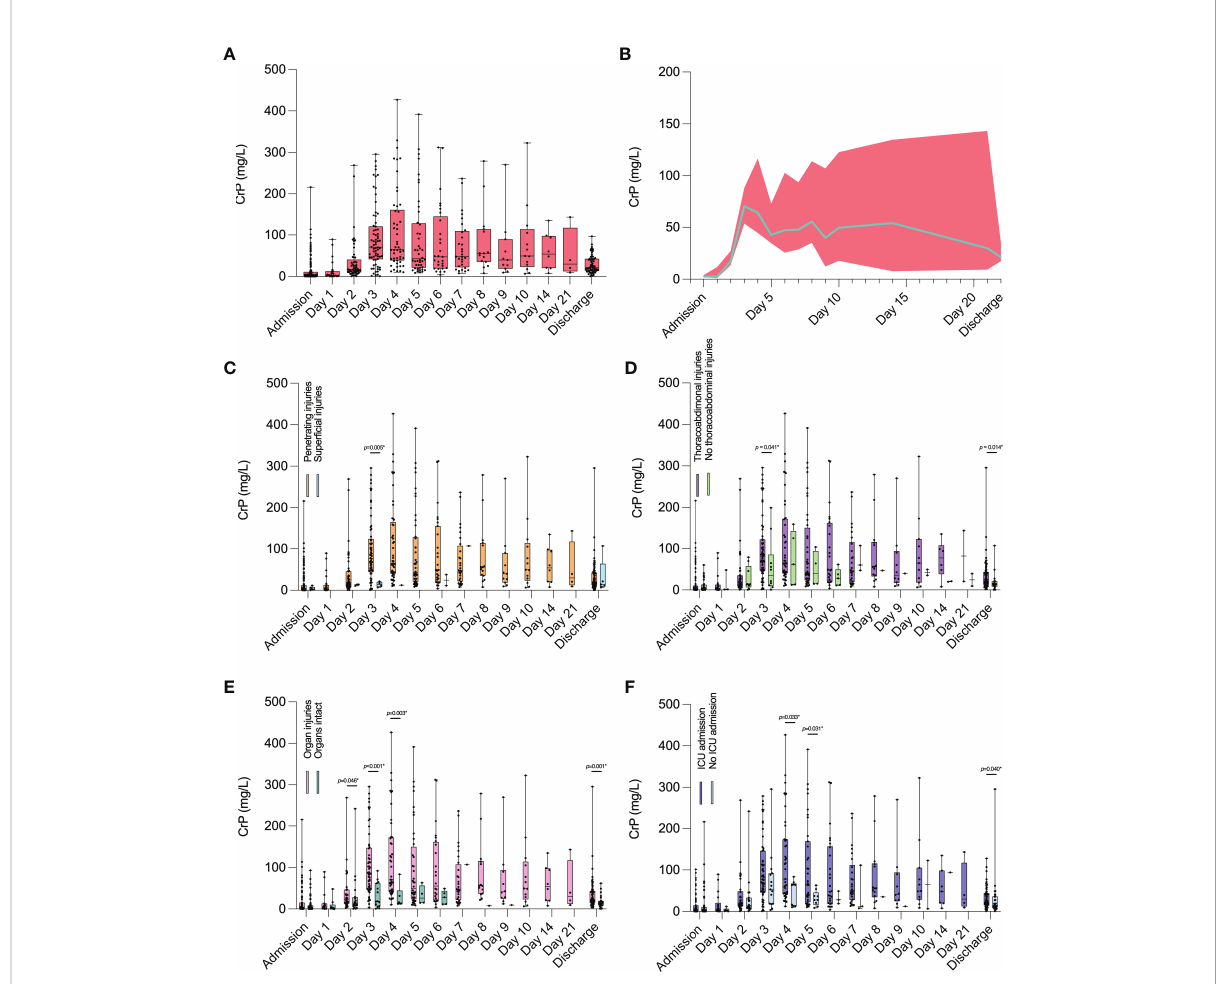
FIGURE 5 Longitudinal development of daily CrP levels in patients who suffered stab injuries. (A, B) Values for all patients who suffered stab injuries. (C) Comparison of CrP values between penetrating and super fi cial injuries during hospitalization. (D) Comparison of CrP values between patients with and without thoracoabdominal injuries, (E) between patients with and without organ injuries, and (F) between patients who were admitted to ICU and those who were not. Physiological CrP concentration: <5 mg/l. Data are presented as median box plots with interquartile range and whiskers from minimum to maximum and in (B) as median line with 95% con fi dence intervals displayed as error bands. CrP, C-reactive